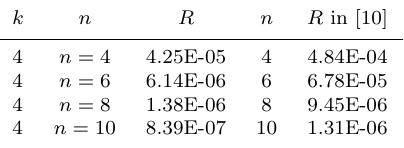
Table 5. Maximum absolute residual error for Example 4 k n R n R in